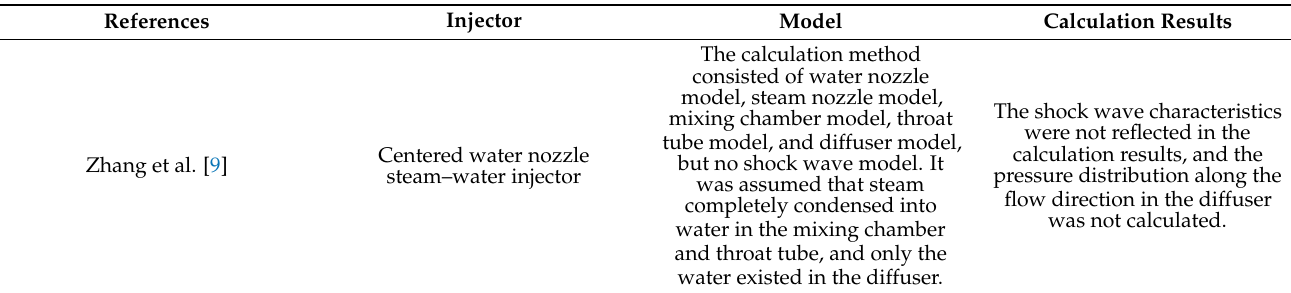
Table 1. Calculation method in existing literatures and this